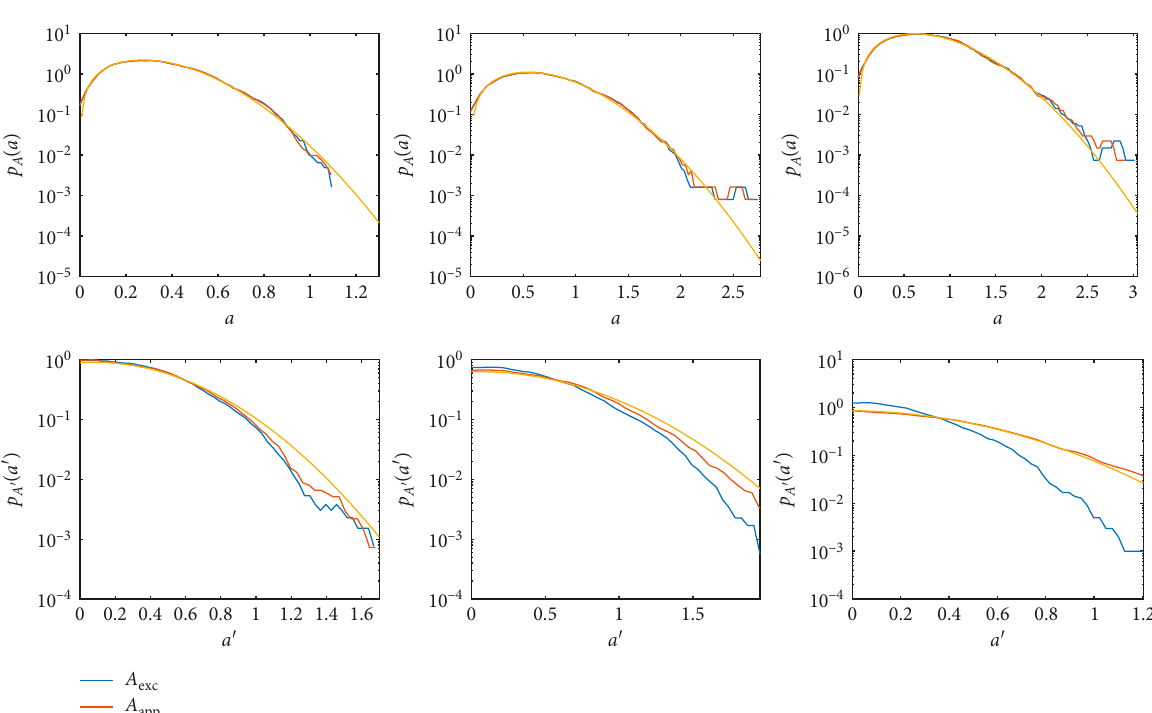
Figure 10: JPDF of A